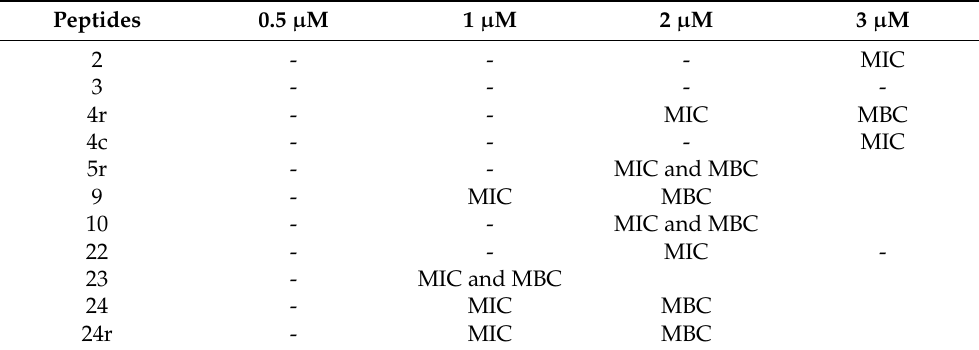
Figure 1. Efficacy of the full-length peptides in inhibiting Xanthomonas campestris pv. campestris , as well as that of the short versions of peptide 4 and the C-terminal-modified analogs (r version), tested at ( A ) 15 µ M and ( B ) 3 µ M. Bars indicate standard errors. Three replicates were performed for each peptide concentration. Two independent experiments were performed. Data were statistically analyzed by a one-way ANOVA followed by the Tukey–Kramer Post Hoc Test. Different letters indicate significant differences at p < 0.05. Table 2. Minimal Inhibitory Concentration (MIC) and Minimal Bactericidal Concentration (MBC) of the most effective trichogin GA IV